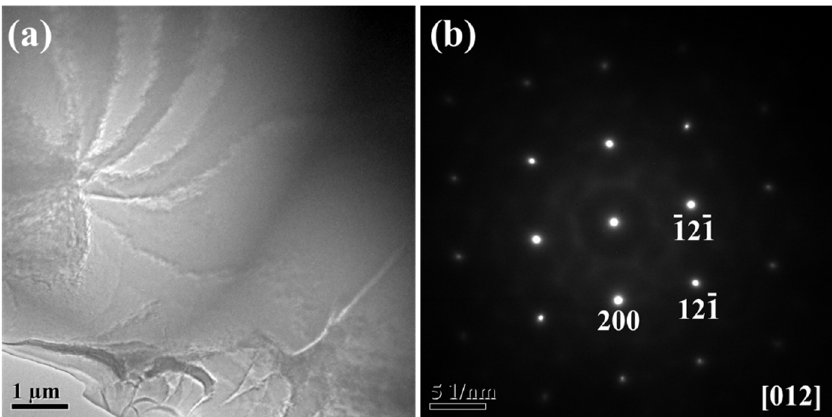
Figure 4. ( a ) TEM bright-field image; ( b ) selected area-electron-diffraction image of the UNbZr al- loy.